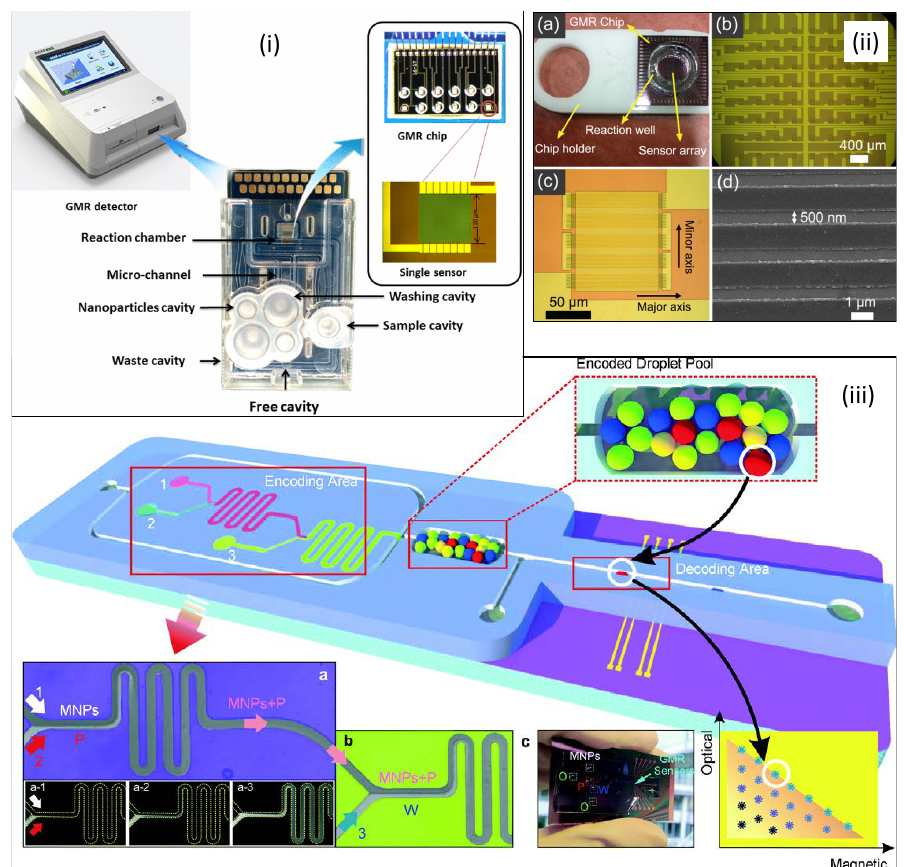
Figure 15. Full systems: (i) high-sensitivity cardiac multibiomarker detection system (reprinted with permission from [67]); (ii) biosensing probe station system for multiple protein assays [68]; (iii) Magnetofluidic platform for multidimensional magnetic and optical barcoding of droplets (Reprinted from [69]—Published by The Royal Society of